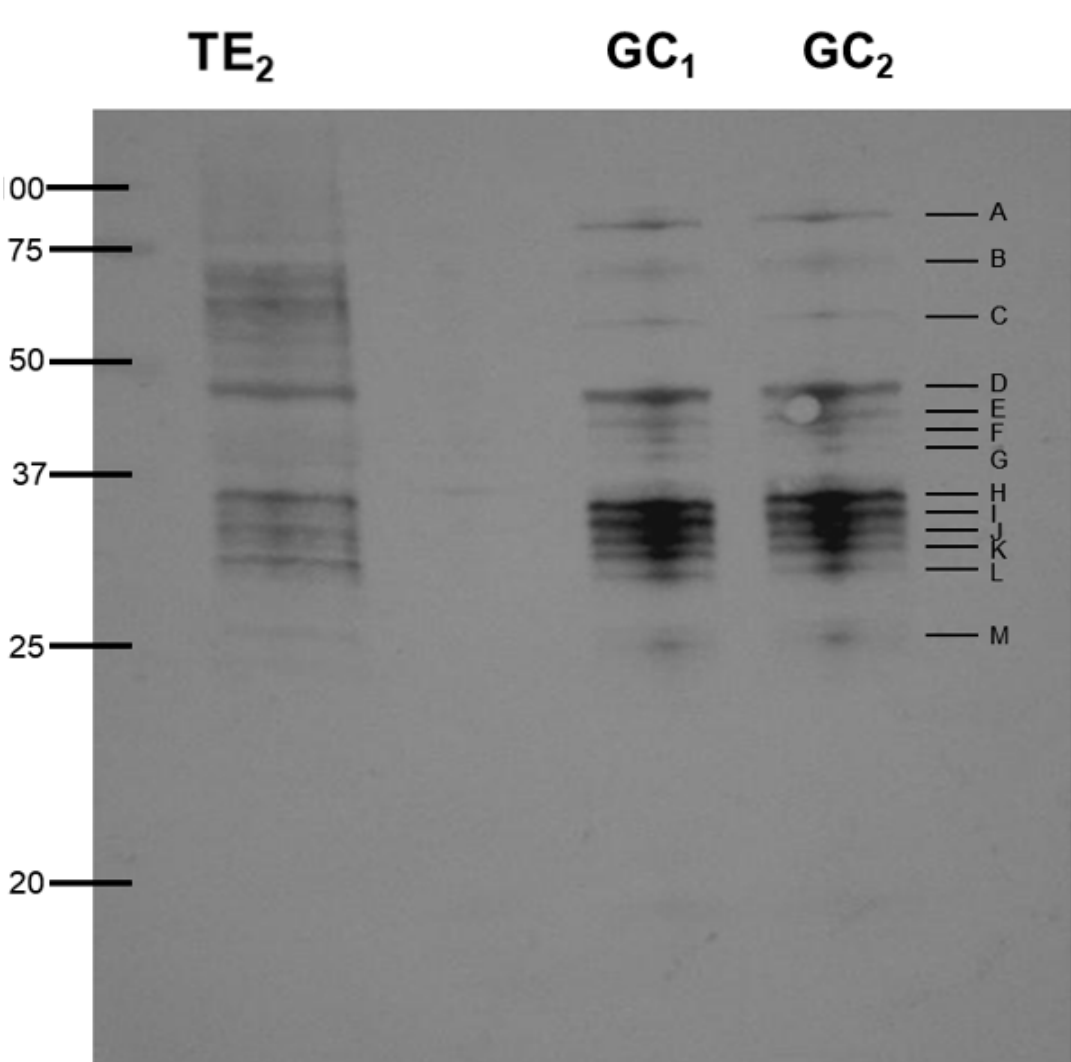
Figure 2. Western blot of total extracts and gland cell extracts probed with pooled serum of Anisakis -positive patients.